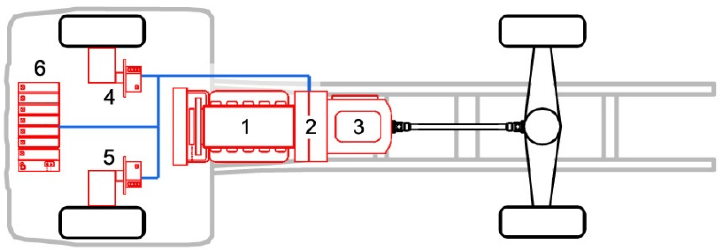
Figure 3. The studied hybrid powertrain intended for a heavy-duty vehicle. 1—internal combustion engine, 2—hybrid module, 3—automated gearbox, 4, 5—front electric drives with reduction gears, 6—traction battery.